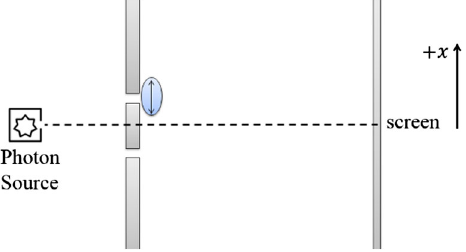
FIG. 4. Basic DSE setup with single photons.